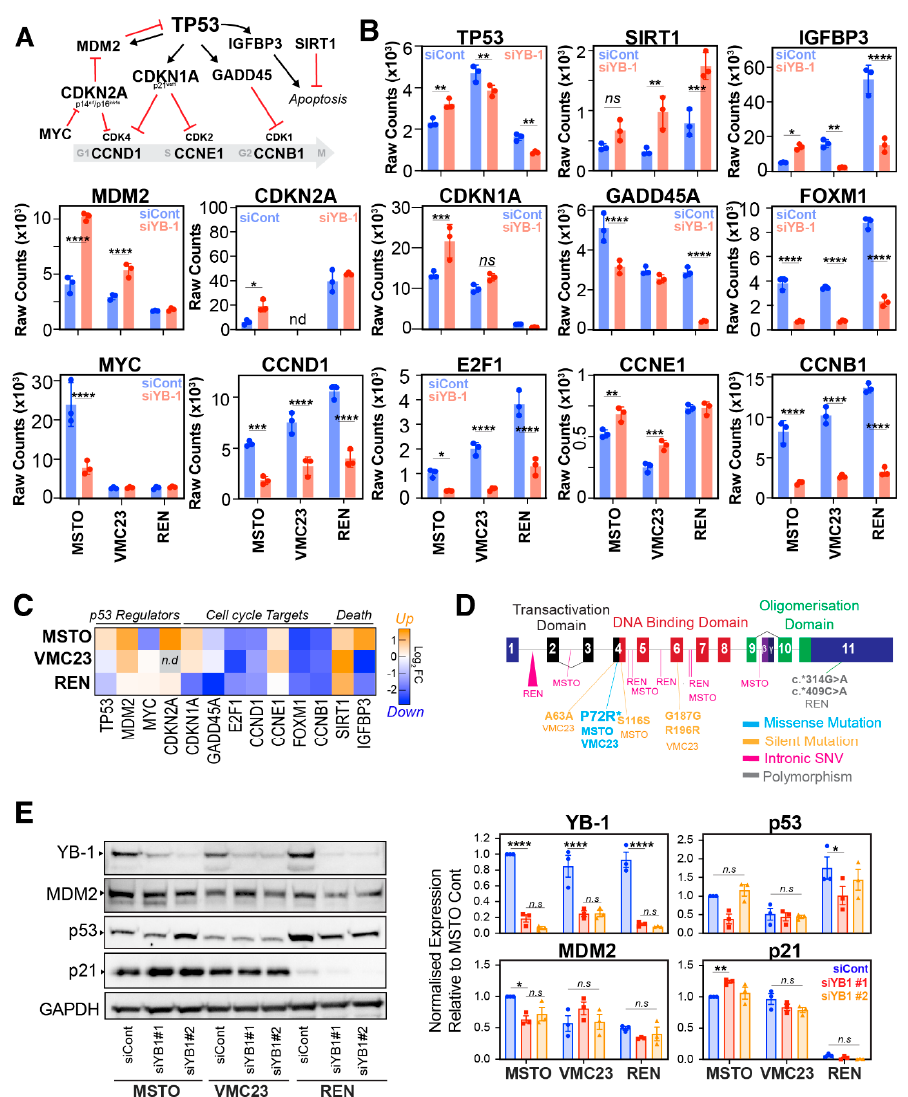
Figure 4. Analysis of the p53 signalling network in YB-1 depleted MPM cells. ( A ) Schematic of major regulators and downstream targets of the p53 pathway. ( B ) Raw counts from RNA-seq analysis for individual genes involved in the p53 pathway across the 3 MPM cell lines. ( C ) IPA based comparative analysis of log-fold (Log 2 FC) expression changes for p53-pathway genes. MSTO-211H = MSTO. ( D ) Summary of mutational analysis of p53 using IGV view to map RNA-Seq reads to TP53 reference gene. ( E ) Immunoblots of whole protein harvested from MPM cells 96 h after transfection with 5 nM of either control (siCont) or YB-1 siRNA (siYB-1 #1 and #2). Western blot analysis of total protein for YB-1, MDM2, p53, p21, and GAPDH (loading control). * p < 0.05, ** p < 0.01, *** p < 0.001, **** p < 0.0001, not significant (n.s).